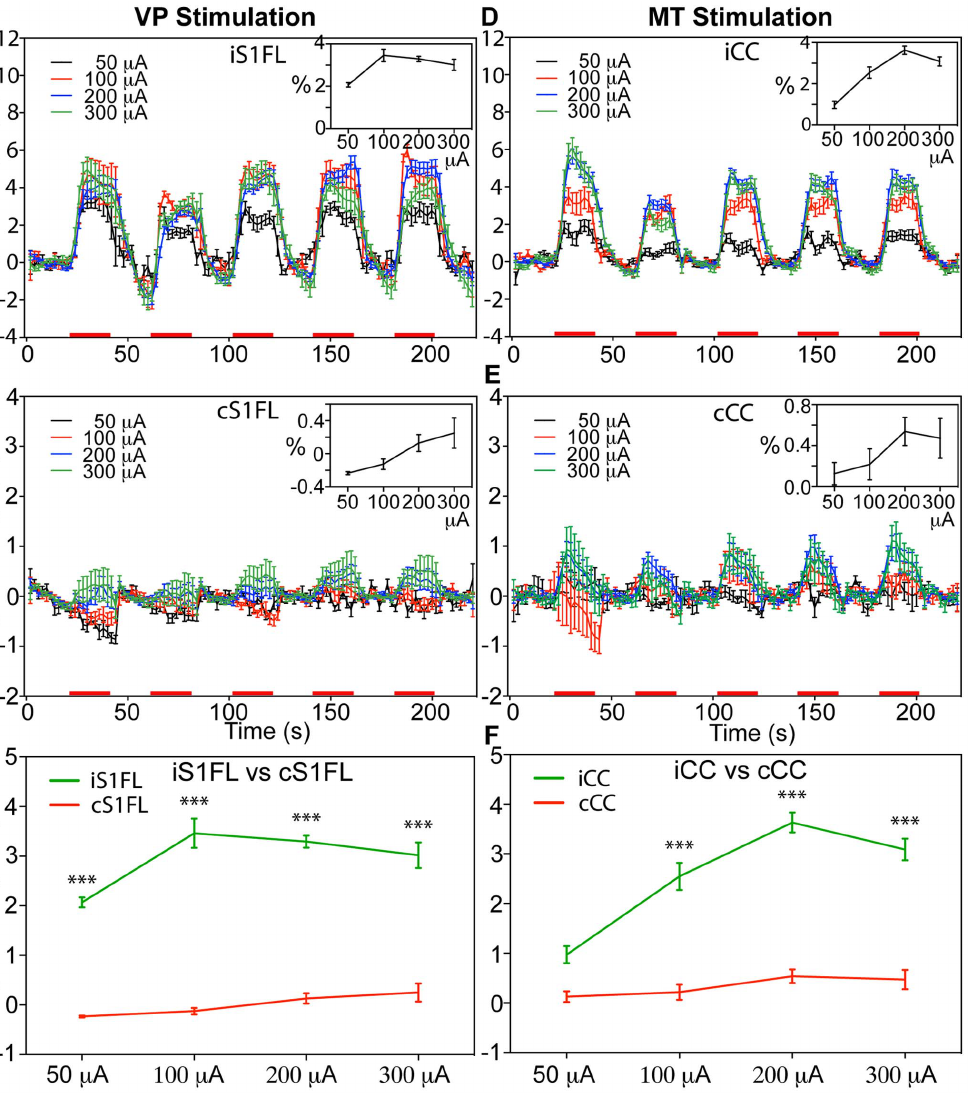
Figure 4. Comparison of BOLD signal changes in the cortical targets by various thalamic stimulation intensities. Mean time course (mean 6 SEM, n=4) of BOLD signal changes within the iS1FL (A) and cS1FL (B) at four stimulus intensities. Average time course (mean 6 SEM, n=6) of BOLD signal changes within the iCC (D) and cCC (E) at four stimulus intensities. Red bars under the time axis show the periods of electrical stimulation. The mean BOLD response amplitude (average change, %) within the five stimulus blocks is shown against the stimulus intensity in the inset and enlarged in (C) and (F). (*** p , 0.0005, two-way ANOVA with Newman-Keuls posttest).